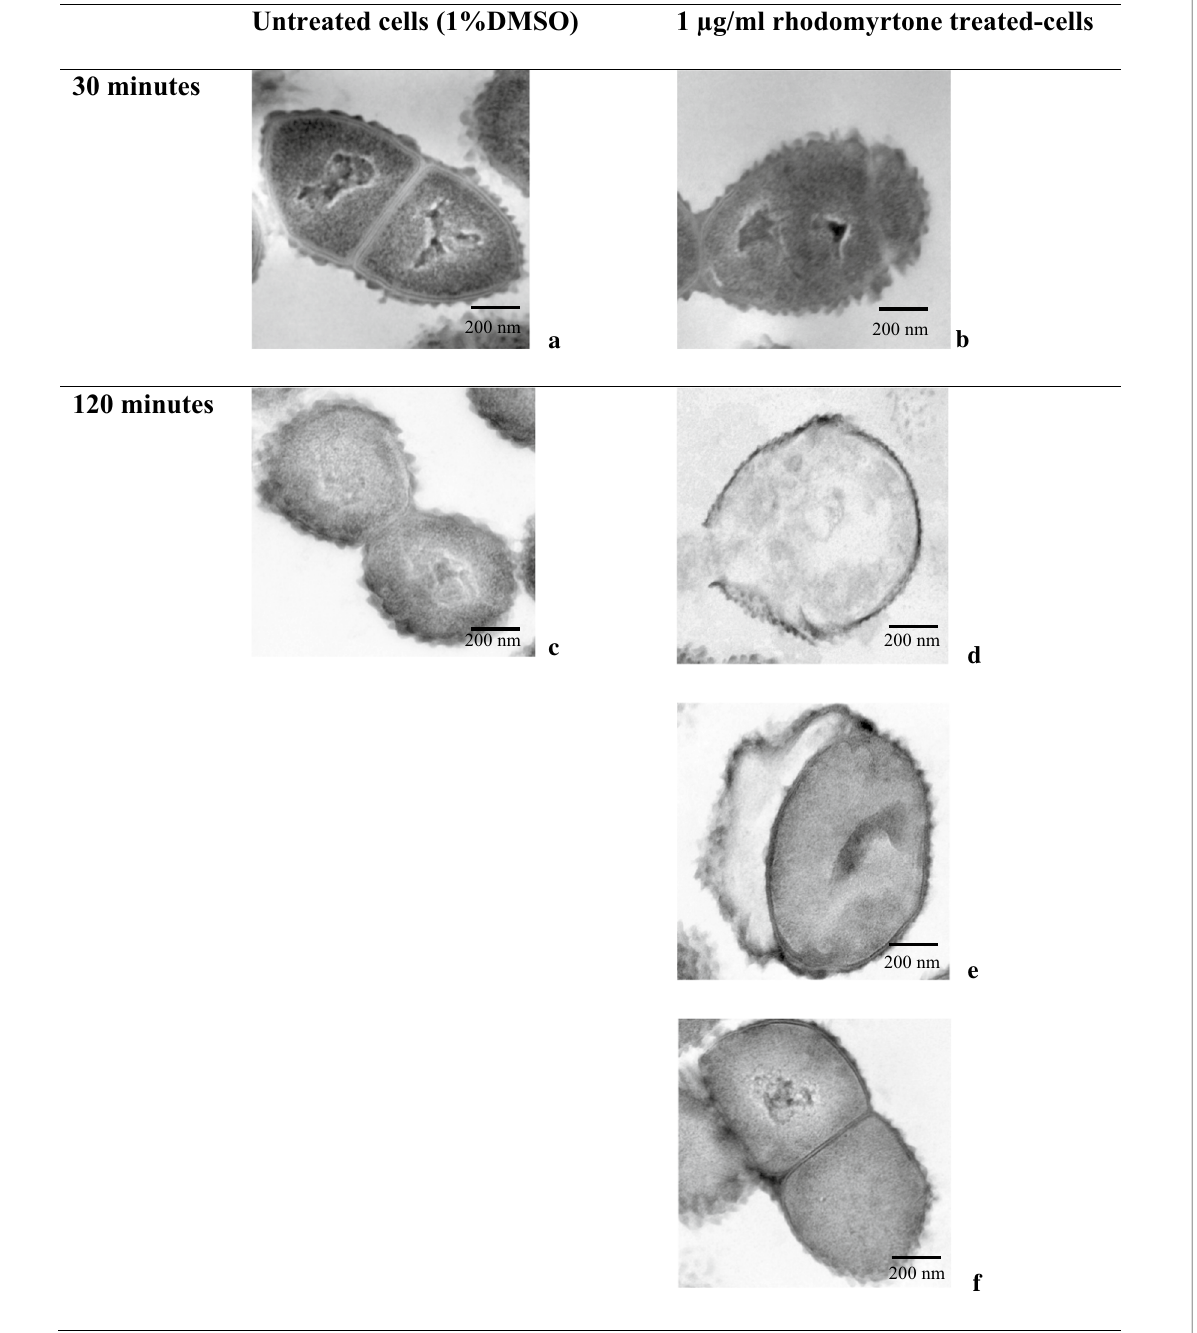
Fig. 6 Transmission electron microscopy demonstrating the effects of rhodomyrtone on Streptococcus suis nucleoid segregation, septum formation and cell morphology. Recombinant S. suis ParB-GFP were treated with addition of 1 µg/ml of rhodomyrtone for 30 min ( b ) and 120 min ( d – f ). Cultures supplemented with 1%DMSO for 30 min ( a ) and 120 min ( c ) were used as untreated control culture. Black arrow indicated incomplete-segregated nucleoid. Scale bar 200 =